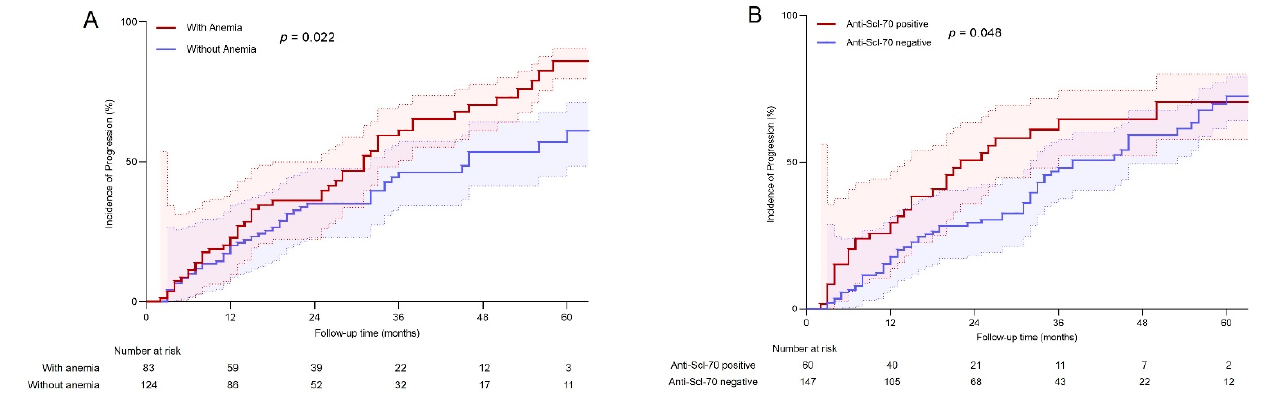
Figure 2. Univariate Cox cumulative incidence plot for time to organ damage progression in SSc patients. ( A ) With or without anemia; ( B ) positive or negative anti-Scl-70 autoantibody. SSc, sys- temic sclerosis.